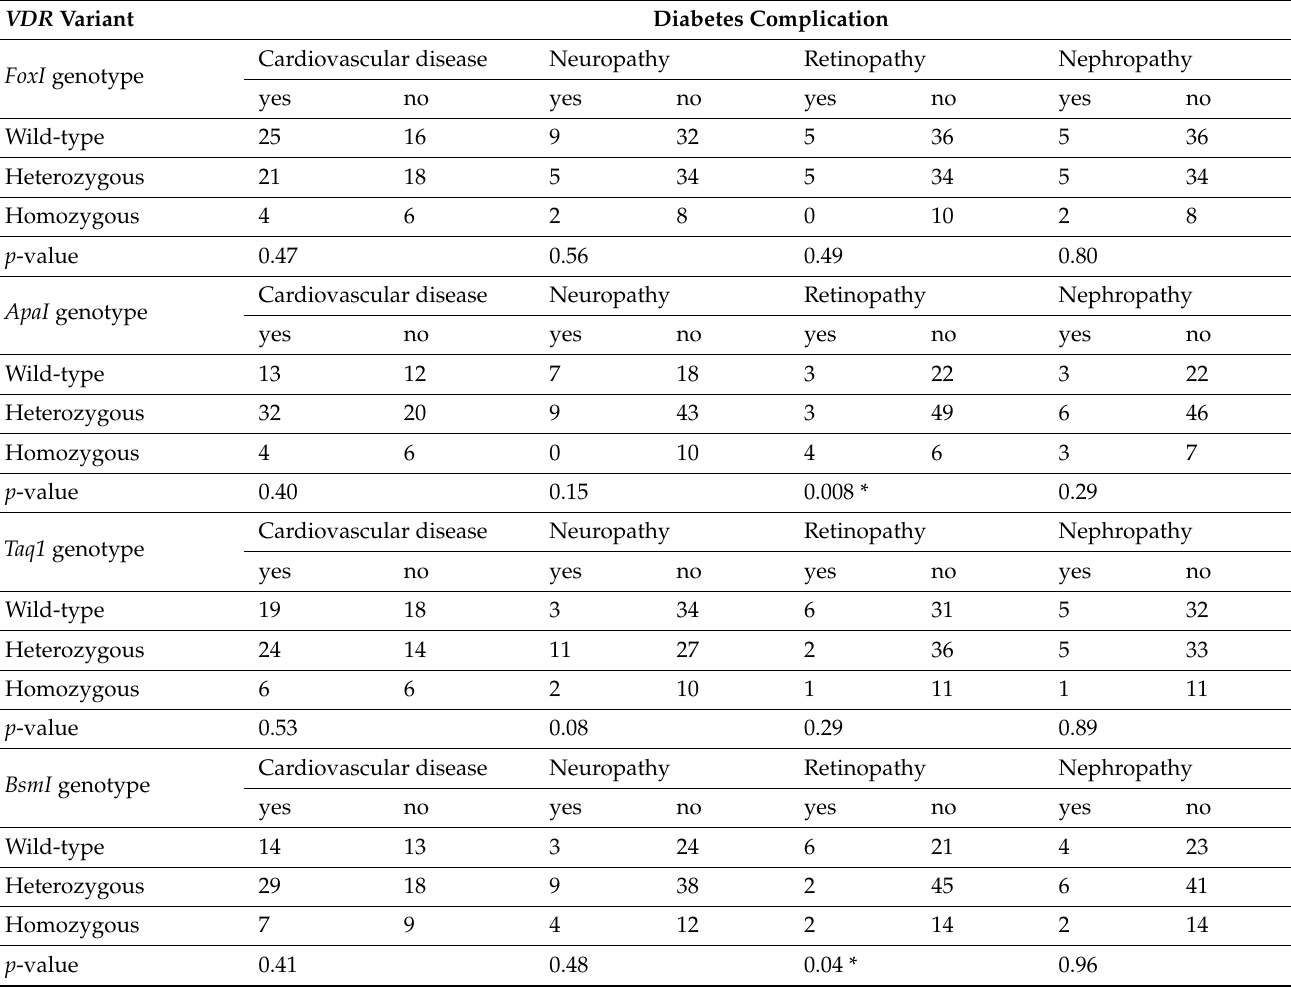
Table 6. Associations of VDR FoxI , ApaI , Taq1 , and BsmI variants with diabetes